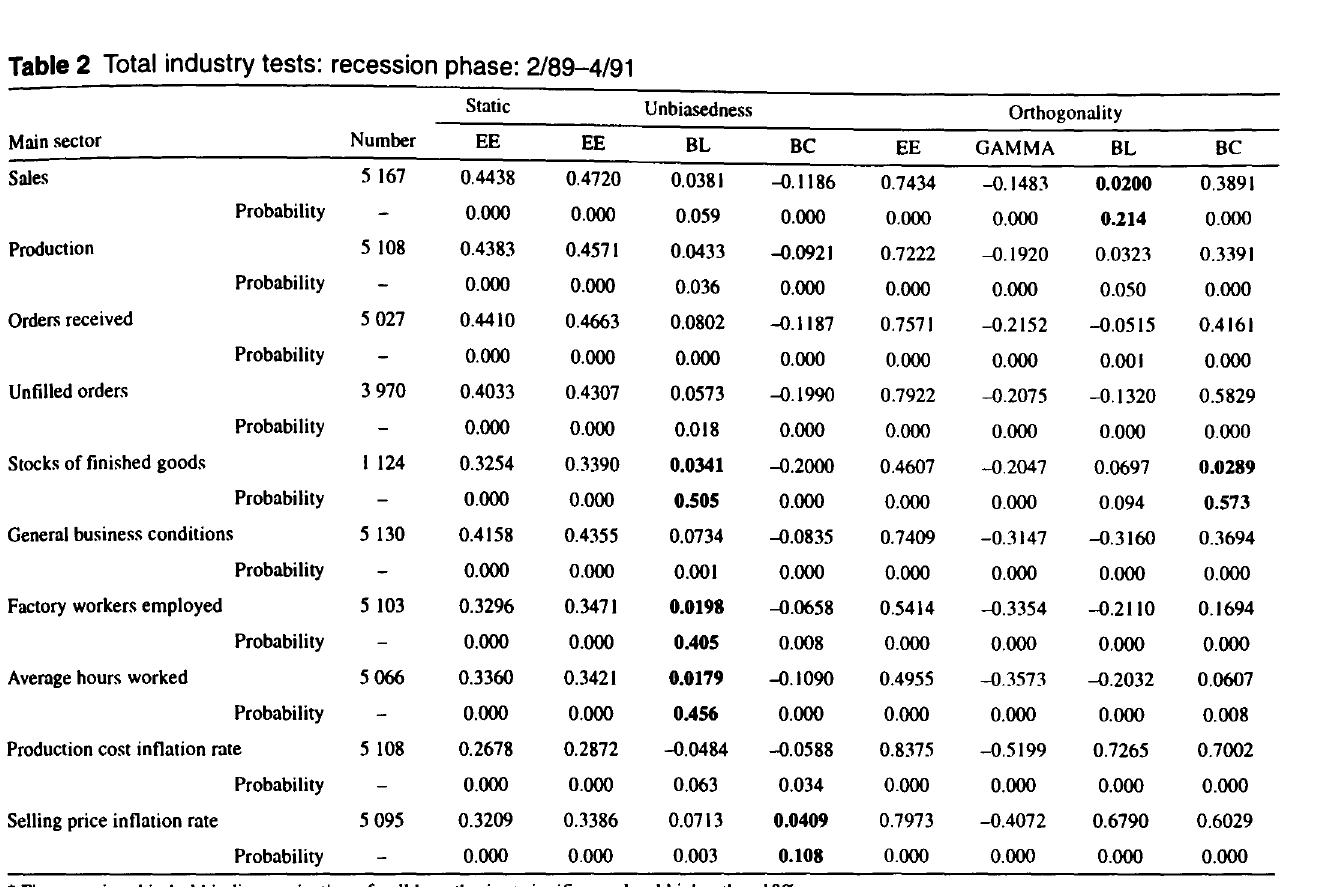
Table 2 Total industry tests: recession phase: